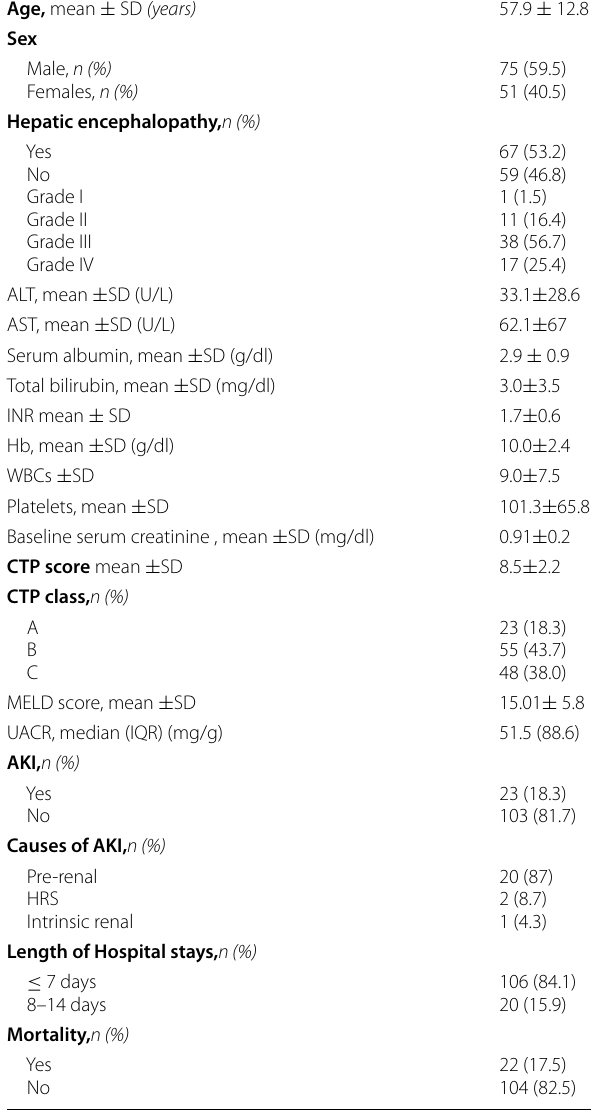
Table 1 Baseline characteristics of the included cirrhotic